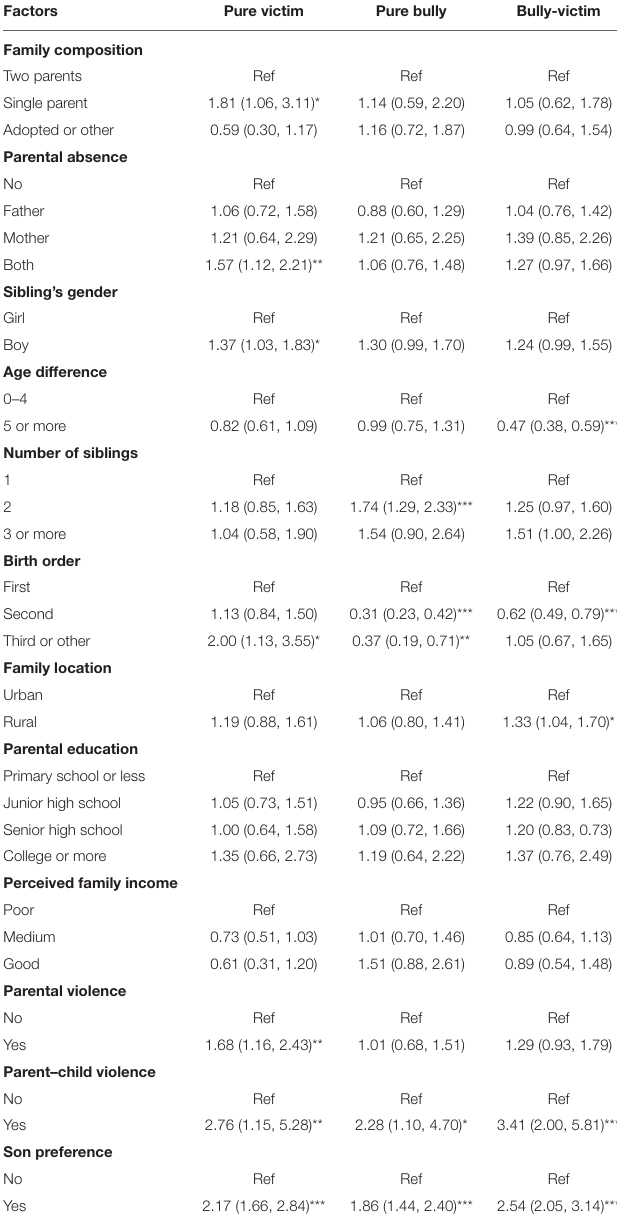
TABLE 4 | Multinomial logistic regression of roles of sibling bullying among girls ( N = 3456). Factors Pure victim Pure bully